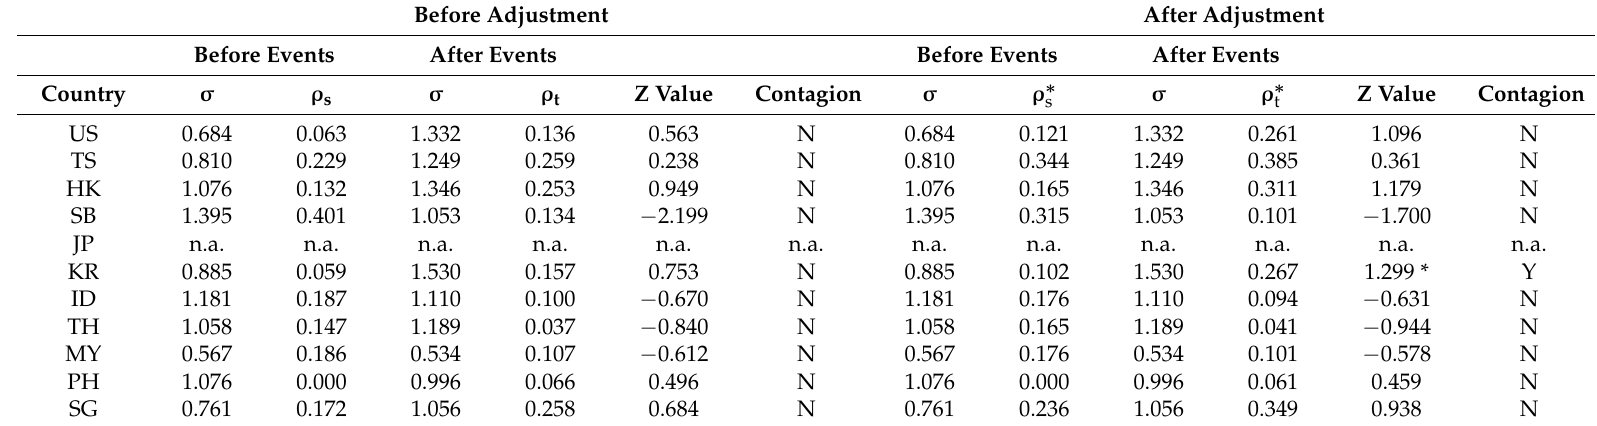
Table 5. The Correlation Coefficients after heteroscedasticity biases adjustment: Japan’s 3.11 earthquake. Before Adjustment After Adjustment Before Events After Events Before Events After